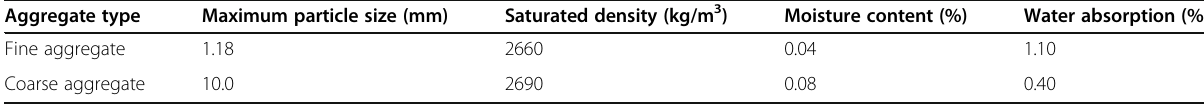
Table 2 Properties of fine and coarse